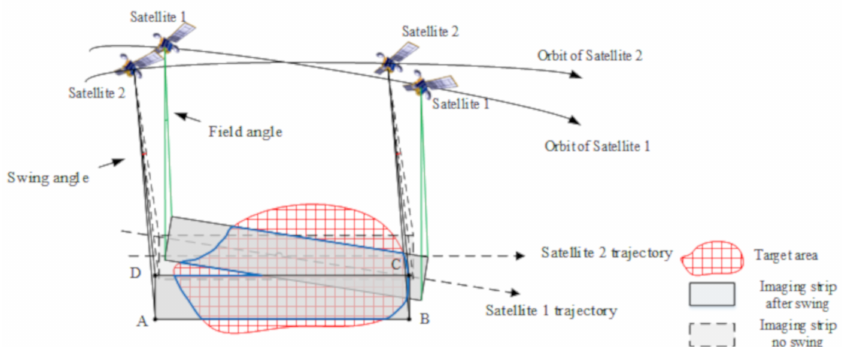
Figure 5. Imaging strips from di ff erent satellites and their